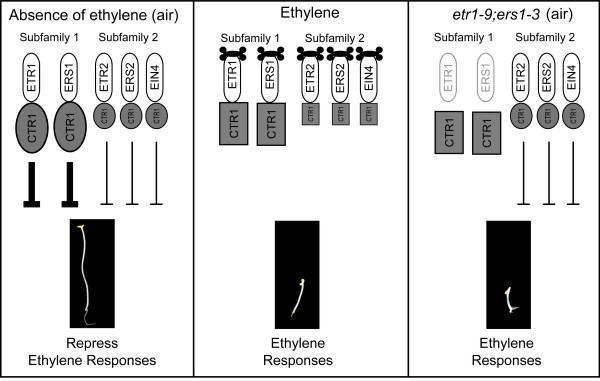
Model for signaling by ethylene receptors. CTR1 (shown in gray) interacts with all five receptors, but subfamily 1 receptors activate CTR1 to a greater extent than subfamily 2 receptors. In the absence of ethylene (in air), the kinase domain of CTR1 actively represses ethylene responses. Ethylene binding to the receptors induces a conformational change in CTR1 that reduces its kinase activity, thereby relieving repression of the ethylene response pathway. Loss of subfamily 1 receptors (the etr1;ers1 mutant), leads to the stimulation of ethylene responses because there is not enough active CTR1 to suppress the pathway. In the figure, active CTR1 is indicated by a circle and inactive CTR1 by a square; the size of the CTR1 symbol indicates its relative contribution to signaling.